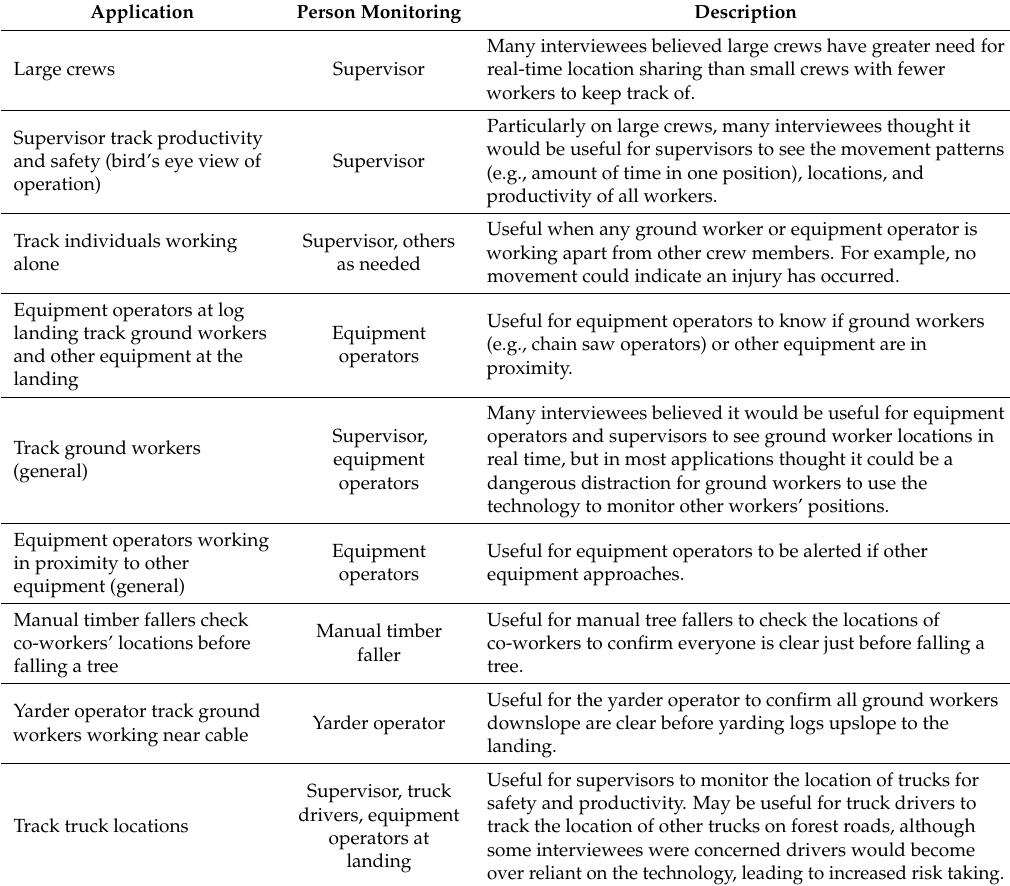
Figure 2. Percent of survey respondents reporting frequency of carrying a two-way radio, by job title. Table 8. Summary of interview results related to most appropriate uses of real-time location-sharing technology on logging operations.